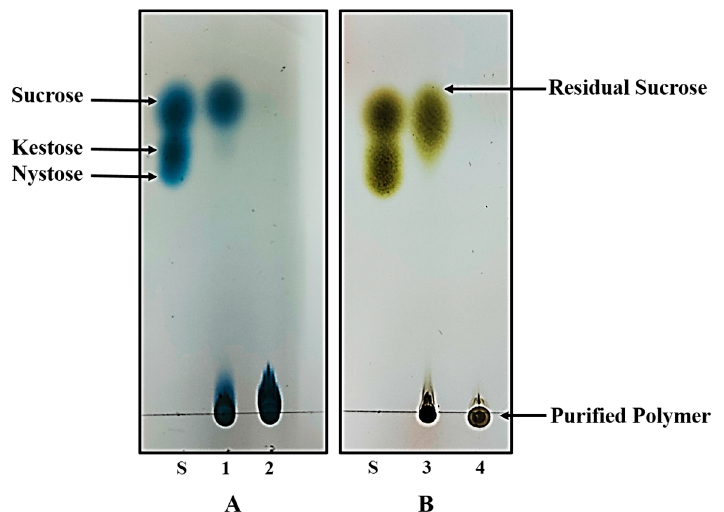
Figure 1. Thin layer chromatography analysis of the exopolysaccharide products synthesized by L. gasseri DSM 20604 ( A ) and W. cibaria M3b ( B ). 1: Inulin containing broth of L. gasseri culture; 2: Purified inulin. 3: Dextran containing broth of W. cibaria culture; 4: Purified dextran.